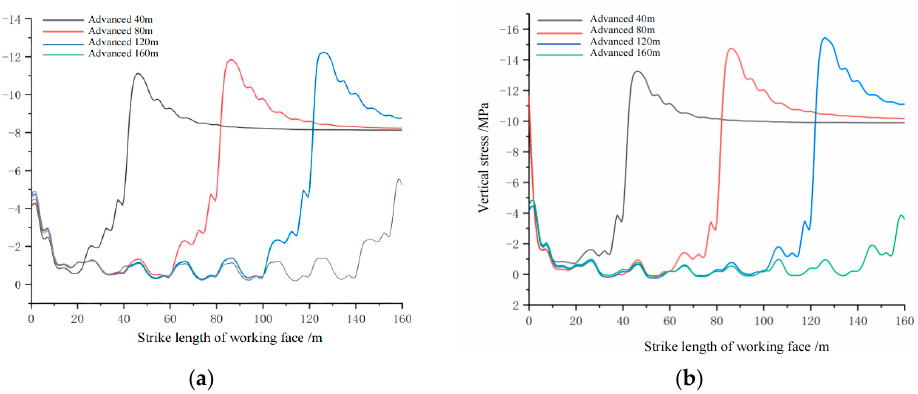
Figure 9. Evolution characteristics of main roof stress. This figure shows the relationship between vertical stress and the advanced length of the working face in filling 1/3 and no filling. ( a ) Filling 1/3; ( b ) No filling.